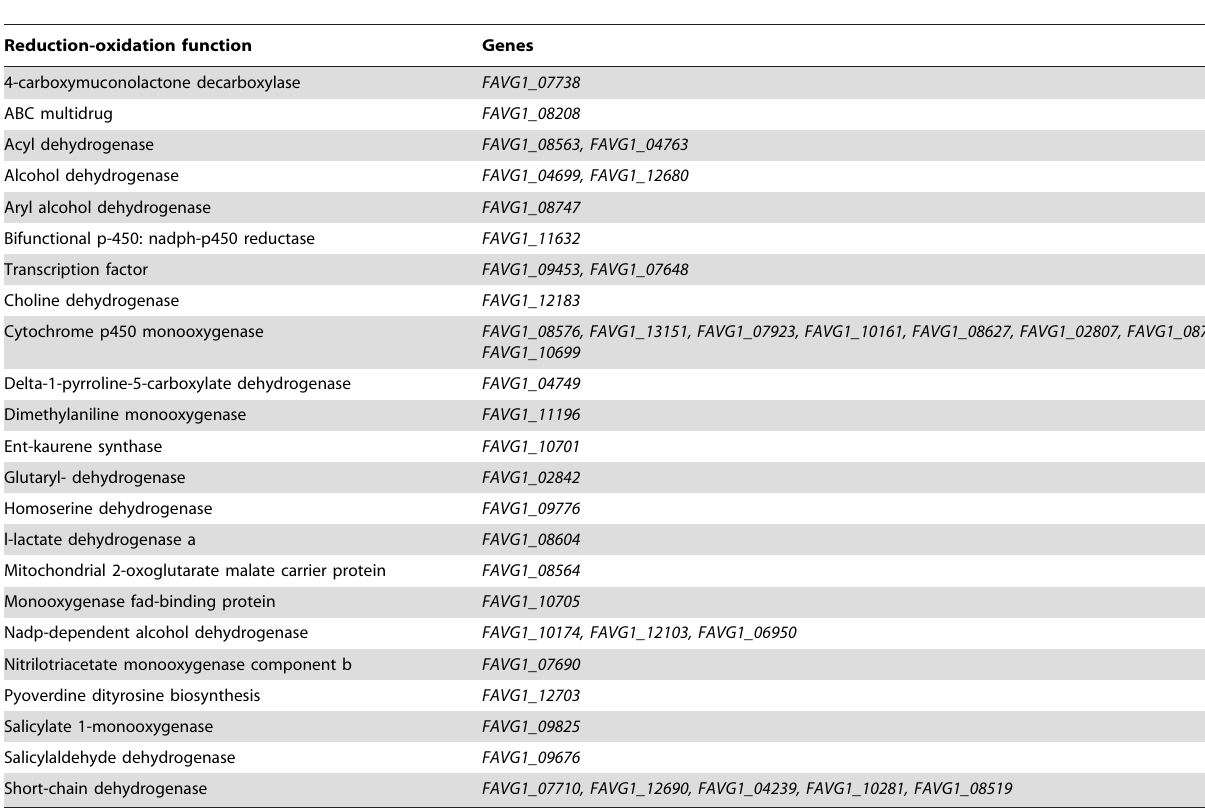
Table 4. Genes annotated as reduction-oxidation process in Fa05001 proteins without orthologs in other genome sequenced Fusaria (with expect .